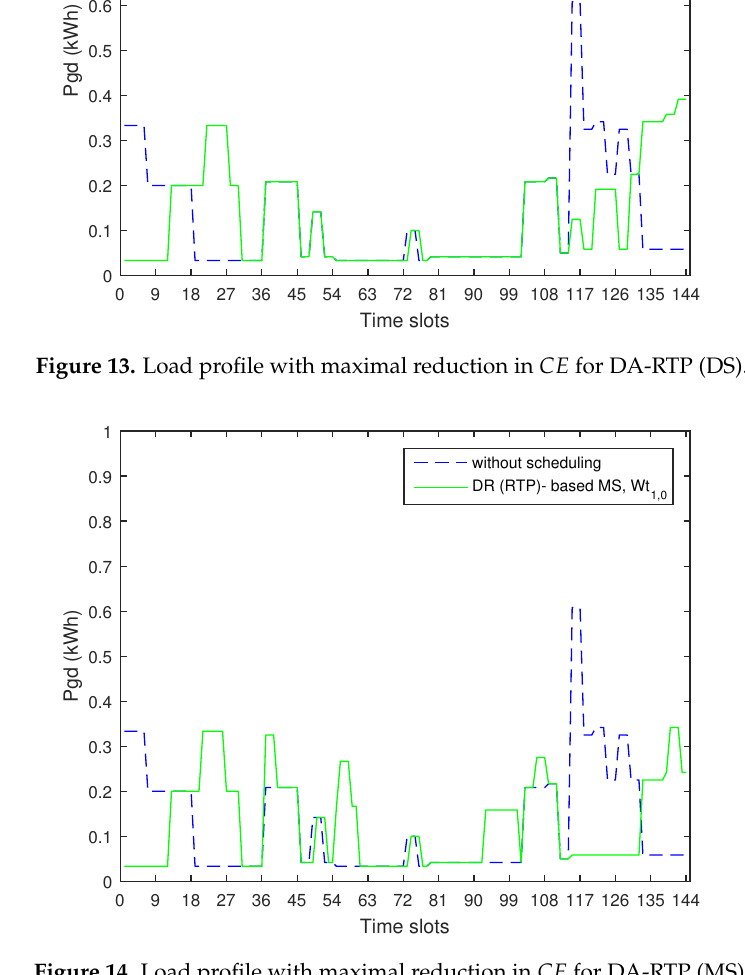
Figure 14. Load profile with maximal reduction in CE for DA-RTP